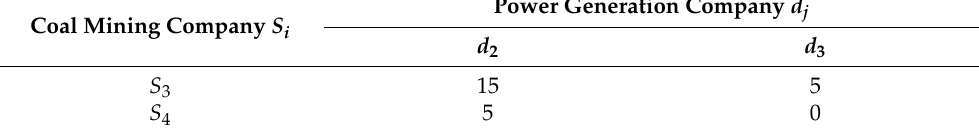
Table 4. Allocation after